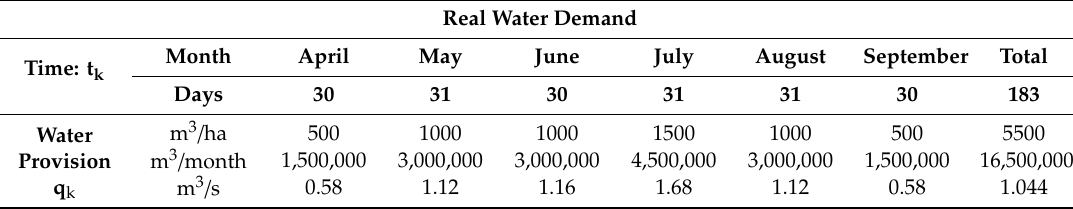
Table 1. Water demand in the study case.